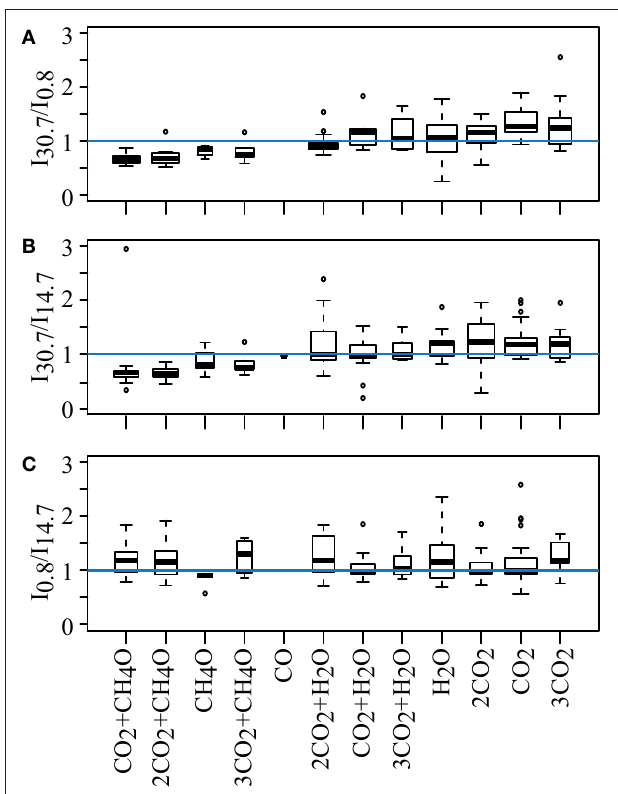
FIGURE 5 | Fragmentation of 18 nominal masses at different salinities (0.8, 14.7, 30.7, Nov 2012), resulting in 423 identified fragments. Boxplots show normalized intensities of fragments grouped by neutral loss; pairwise comparisons are (A) salinity 30.7 to 0.8, (B) salinity 30.7 to 14.7, and (C) salinity 0.8 to 14.7. Blue line denotes ratio of 1 in pairwise comparisons of samples. Relative intensities of averaged neutral losses did not differ significantly between samples (Wilcoxon rank-sum test, p < 0.01). Box widths are proportional to the number of observations in the